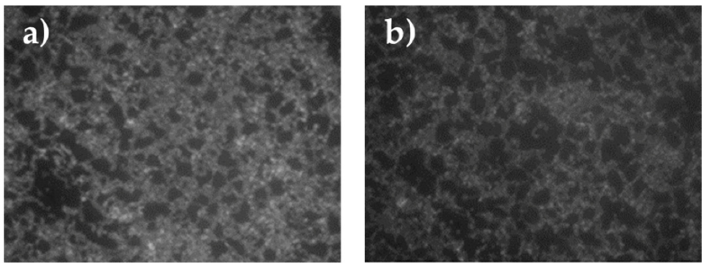
Figure 17. Microbial biofilm formation observed (with direct DAPI count) on the surfaces analyzed in this study (100× immersion) after 60 days of immersion. ( a ) G/C16, ( b ) G/F3.